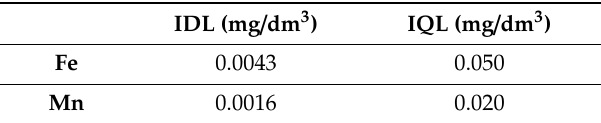
Table 1. The instrumental detection limits (IDL) and instrumental quantification limits (IQL) for the spectrometer iCE 3500 (g / dm 3 ) [24].